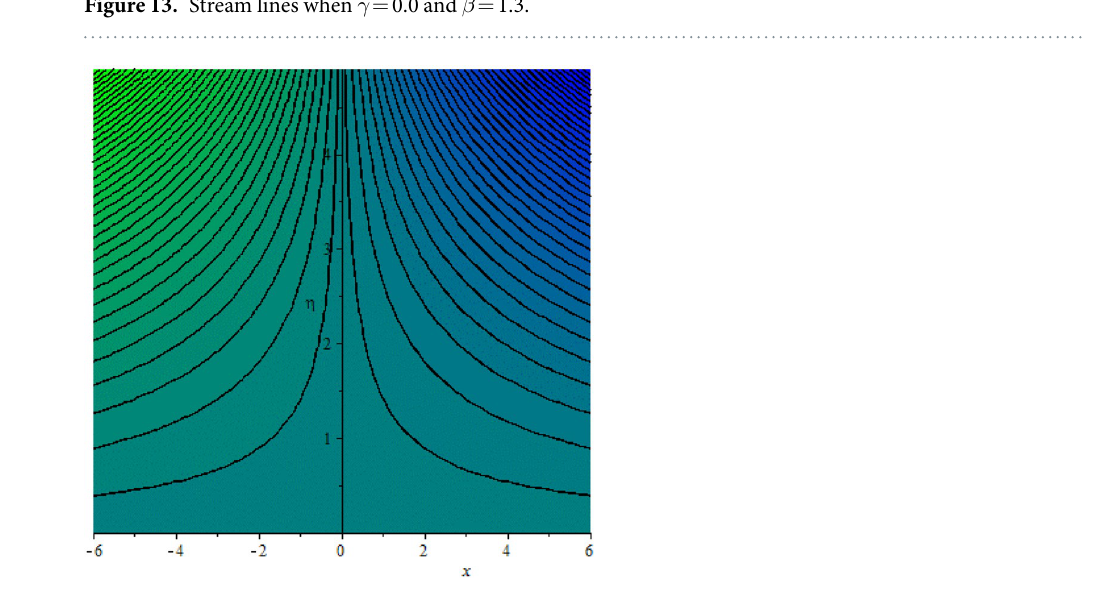
Figure 14. Stream lines when γ = 0.5 and β = 1.3.